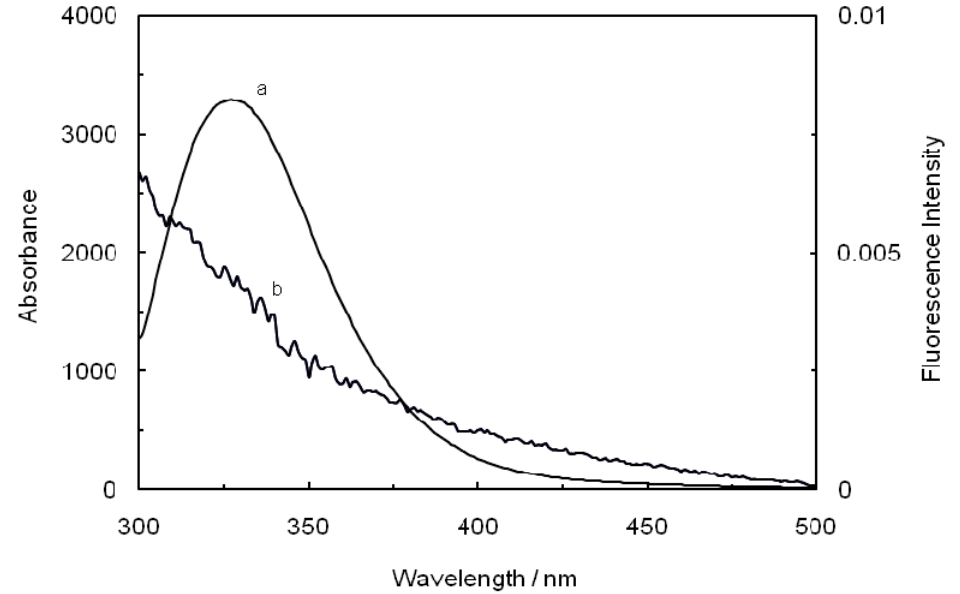
Figure 8. Spectral overlap of the fluorescence spectra of hTf in the presence of ASA (a) with the absorption spectra of ROP (b) at pH 7.4 and T = 298 K. [hTf] = 3.8 × 10 − 3 mM,